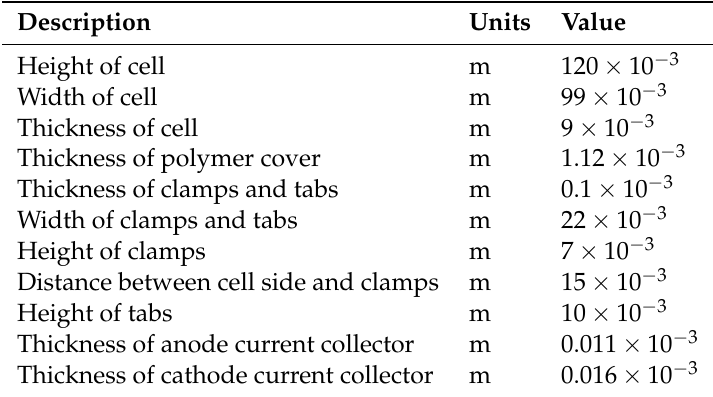
Table A4. List of cell design